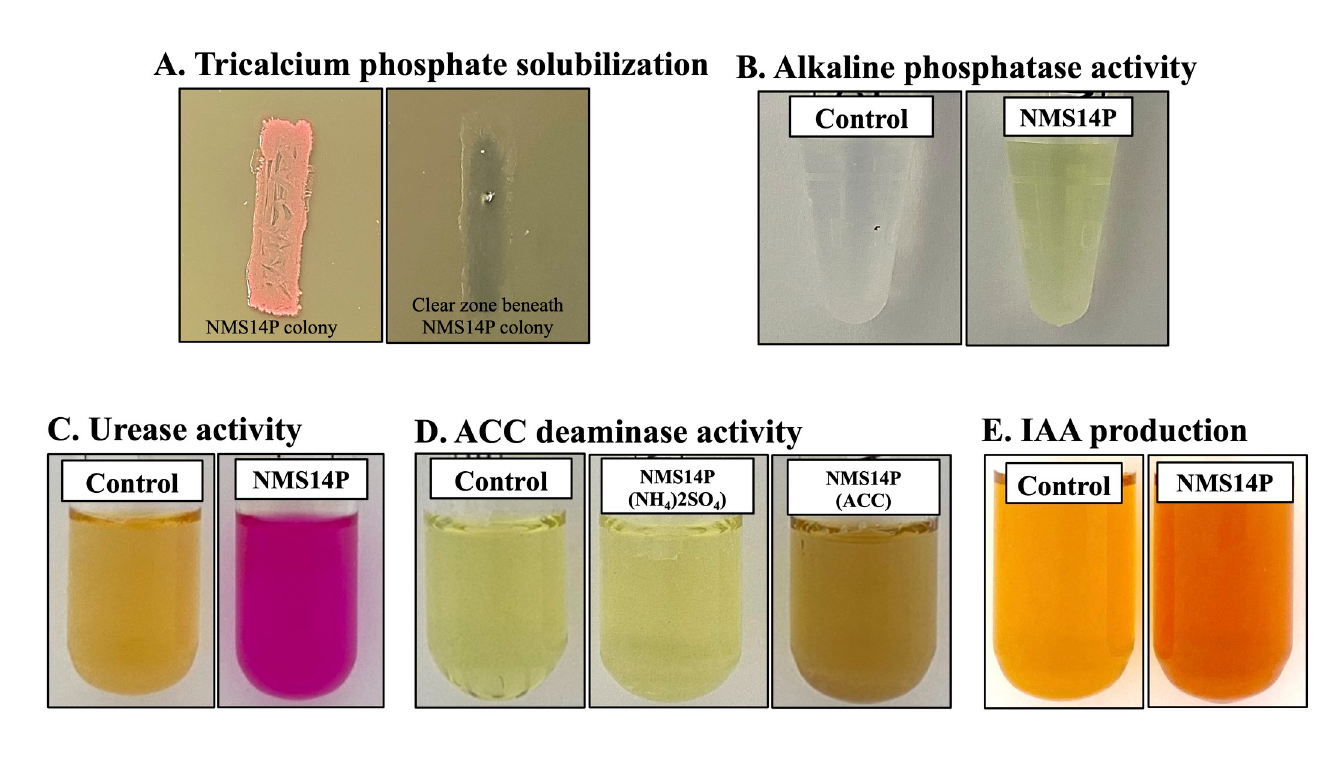
Fig 7. Experimental assays to confirm plant growth-promoting traits of NMS14P. The in vitro tests include (A) inorganic and (B) organic phosphate solubilizations, (C) urease, (D) ACC deaminase, and (E) IAA production.